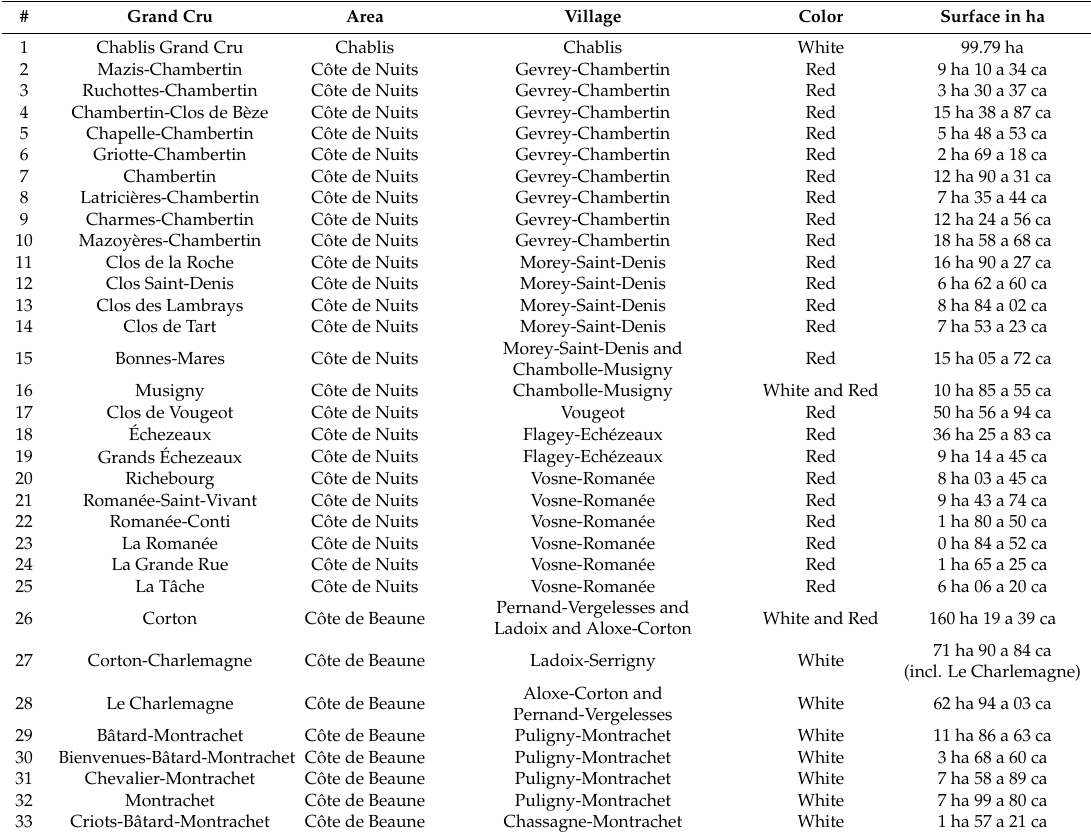
Table 2. List the Grands Crus (presented from North to